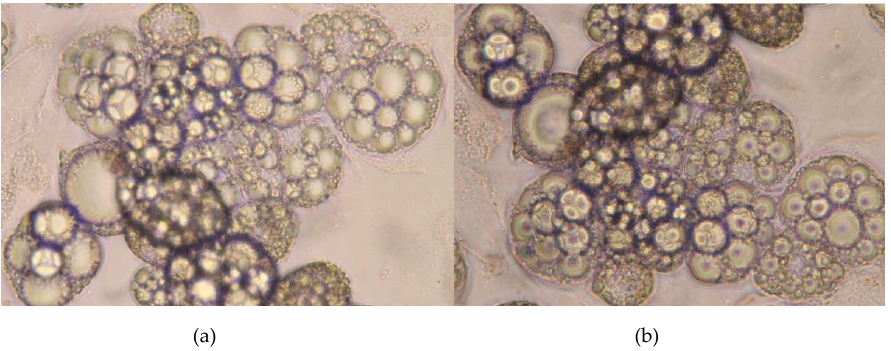
Figure 4. Representative sample of 3t3 adipocytes before ( a ) and after ( b ) treatment by FA isolated from serum of CKD patients. from serum of CKD